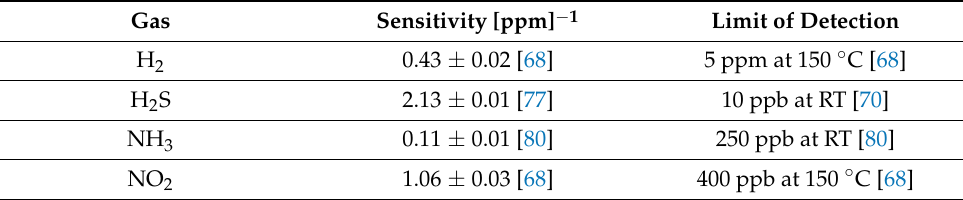
Table 5. Sensitivity to H 2 , H 2 S, NH 3 , and NO 2 for SnSe 2 -based sensors, as well as their limit of